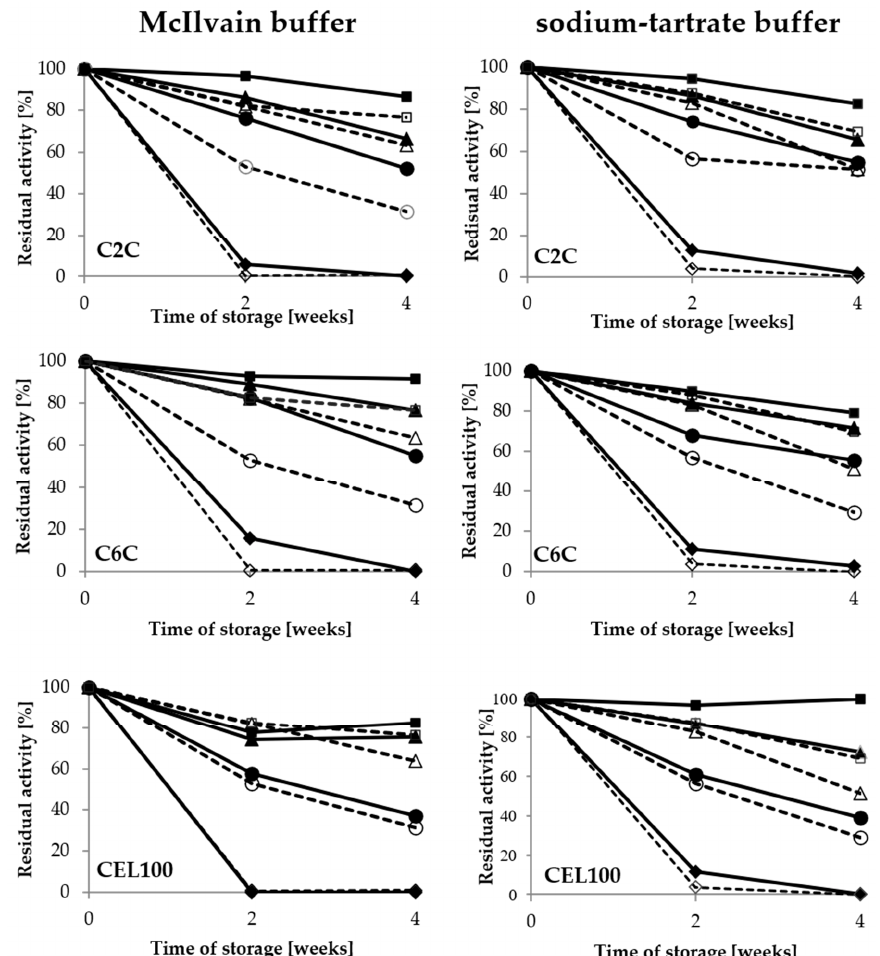
Figure 5. Stability of covalently immobilised laccase activity during 4-week storage in the McIlvain buffer and sodium-tartrate buffer in the range of pH values from 3 to 6; immobilised LAC—filled, free LAC—empty: pH 3—rhombus, pH 4—circle, pH 5—triangle, pH